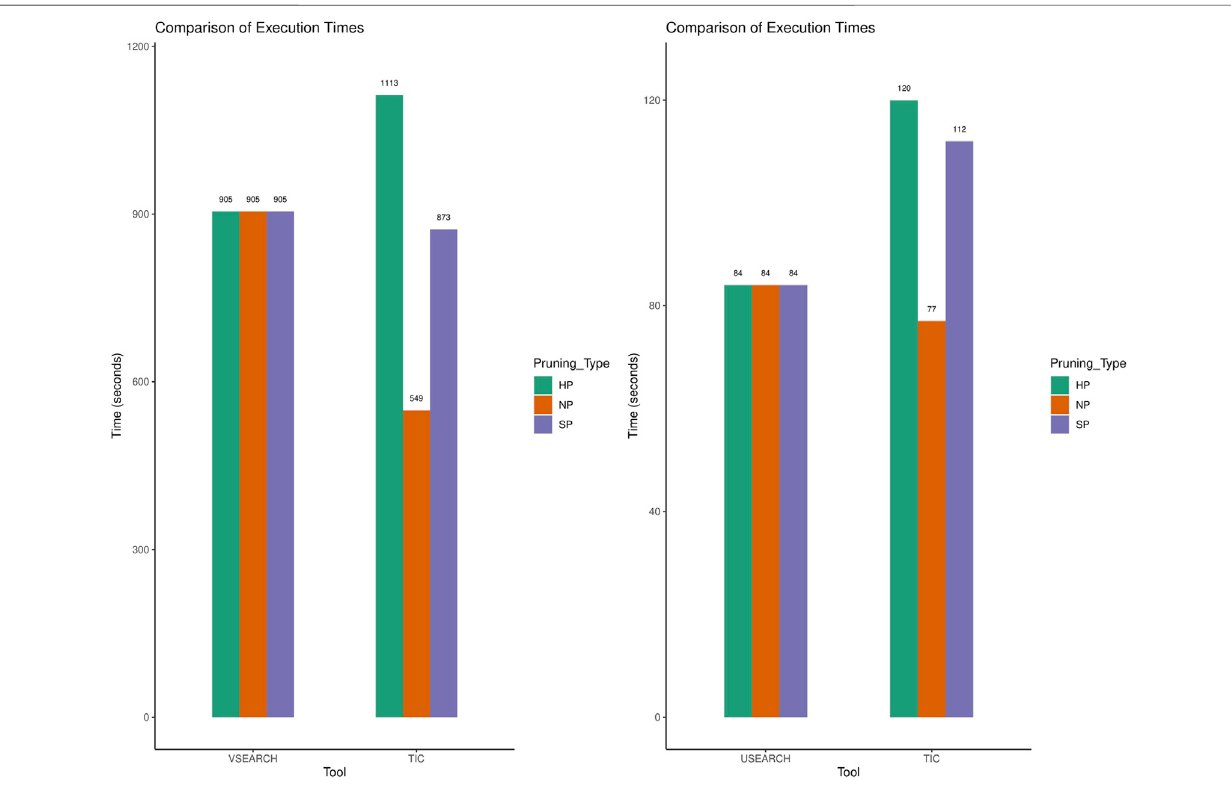
Frontiers in Bioinformatics |